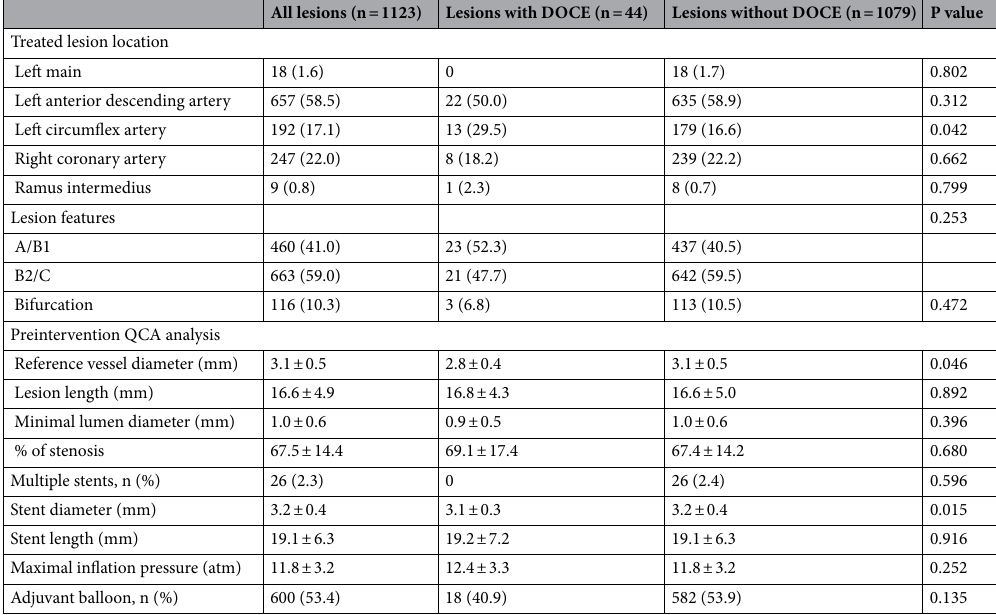
Table 2. Procedural characteristics. DoCE device-oriented clinical end point, QCA quantitative coronary angiography.